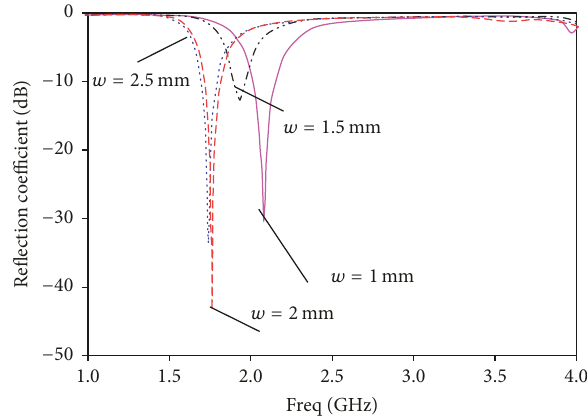
Figure 10: Transfer characteristics of the GP slot for five differ- ent configurations. (a) Config-I, (b) Config-II, (c) Config-III, (d) Config-IV, and (e)